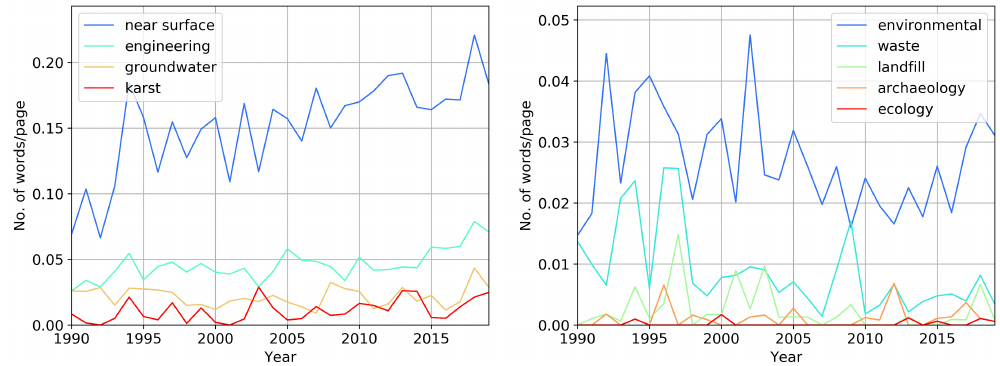
Figure 5. Terms and phrases related to engineering geophysics. “Near surface” curve includes “near surface”, “nearsurface” and “near-surface”; “groundwater” curve includes “ground water” and